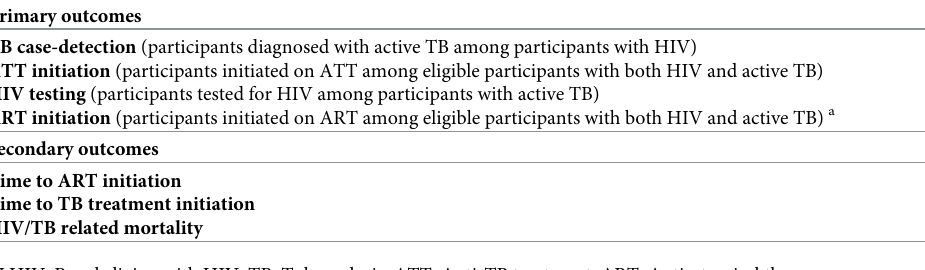
Table 1. Outcomes of the systematic